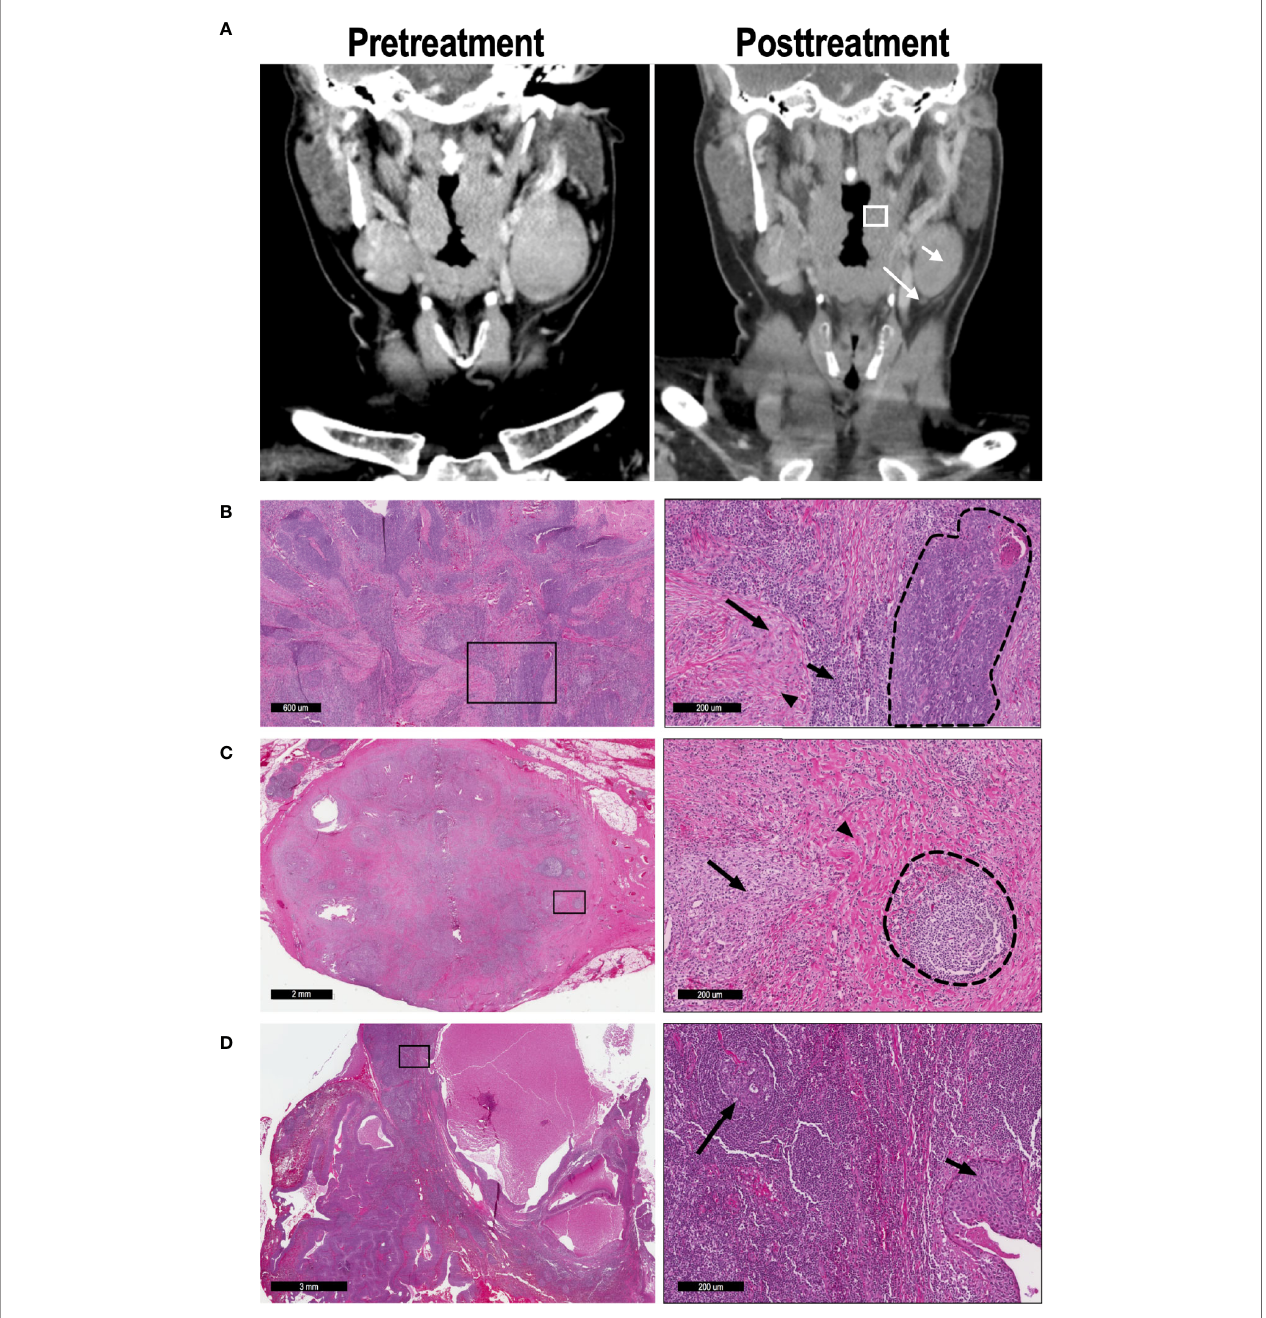
FIGURE 1 | 57 y/o M with P16+, cT2N2 oropharyngeal SCC. (A) CT imaging was performed on day 0 (pretreatment) and day 31 (posttreatment) to determine radiographic treatment effect; representative coronal imaging demonstrates the primary tumor (box), lymph node A (short arrow), and lymph node B (long arrow). (B) Low magni fi cation (left) and high magni fi cation (right) imaging demonstrates a tumor with partial (52%) pathologic treatment effect. In the high magni fi cation image, a nest of viable tumor cells (dashed line) is bordered by lymphocytic in fi ltration (short arrow), macrophages (long arrow), and fi brosis (arrowhead). (C) Lymph node A demonstrated 100% pathologic TE, with no tumor cells evident in the node. High-powered magni fi cation (right) reveals a poorly-formed granuloma (arrow) and extensive fi brosis (arrowhead), leading to distortion of the normal LN architecture. A residual germinal center is also present (dashed lines). (D) Lymph node B exhibited 0% pathologic TE, as seen in the high-magni fi cation image (right). The normal lymph node architecture is preserved (long arrow), and a nest of malignant cells con fi rms tumor invasion (short